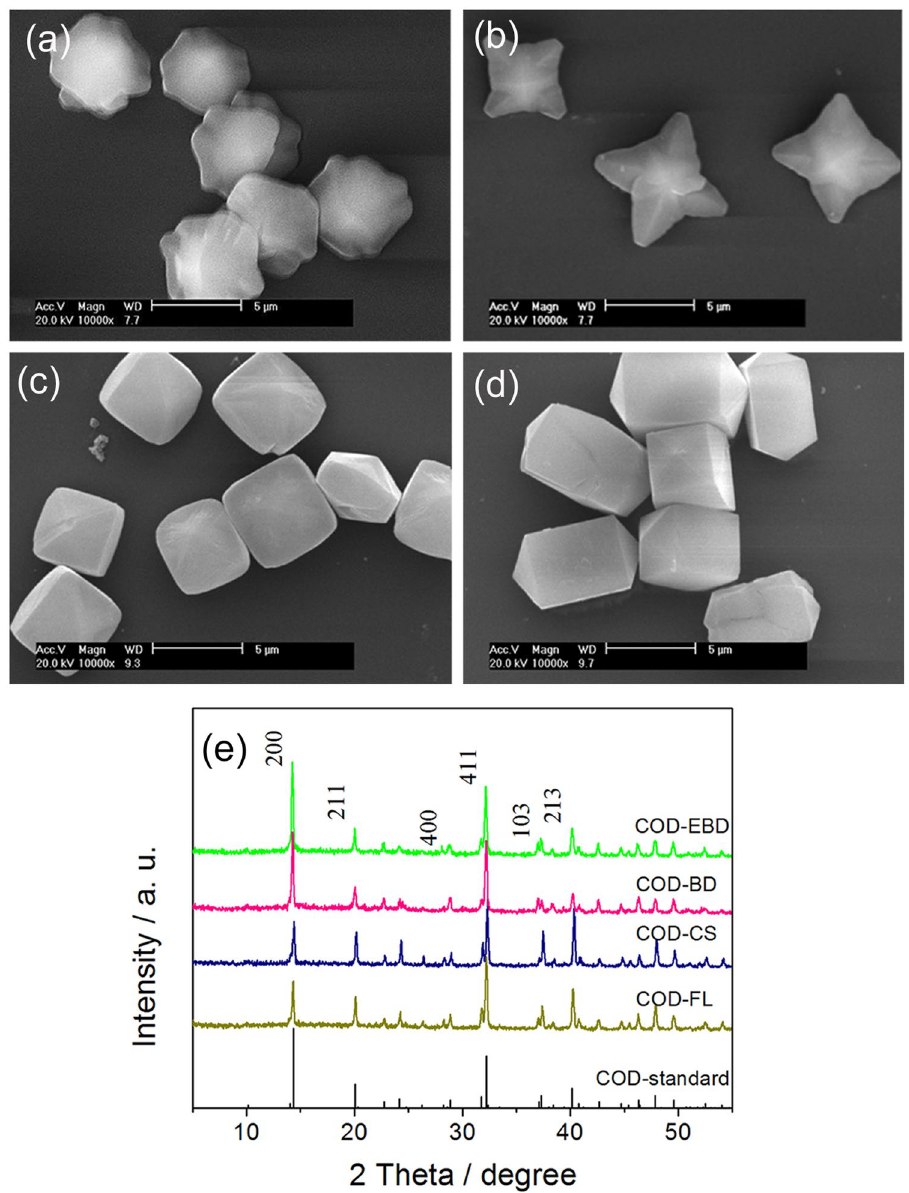
( c ) COD-BD; ( d ) COD-EBD; ( e ) XRD spectra. Scale bars: 5 μ